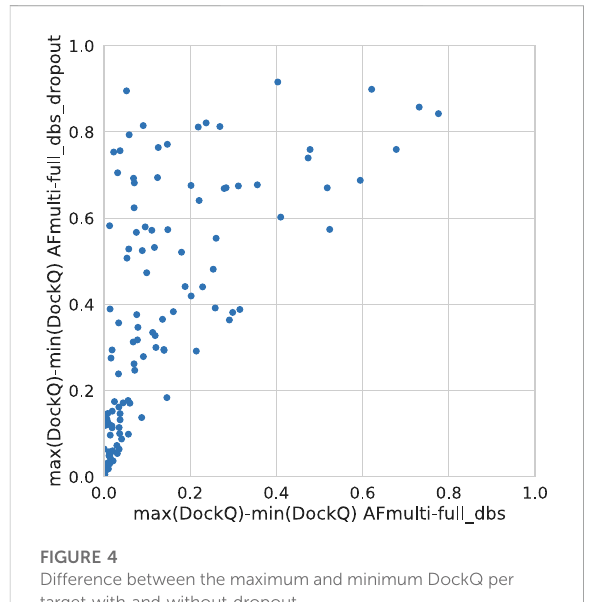
FIGURE 4 Difference between the maximum and minimum DockQ per target with and without